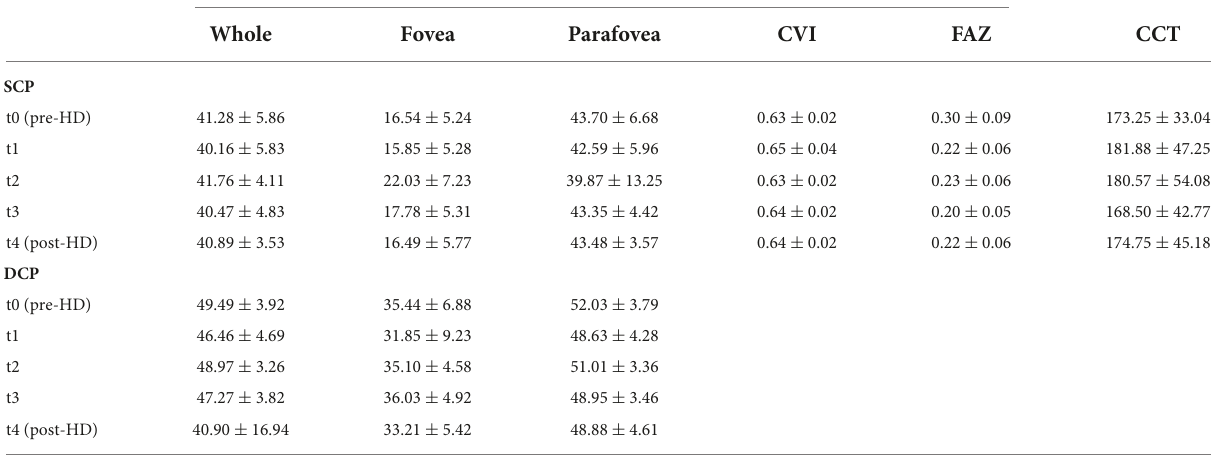
TABLE 4 Dialysis changes in OCT-A metrics in the